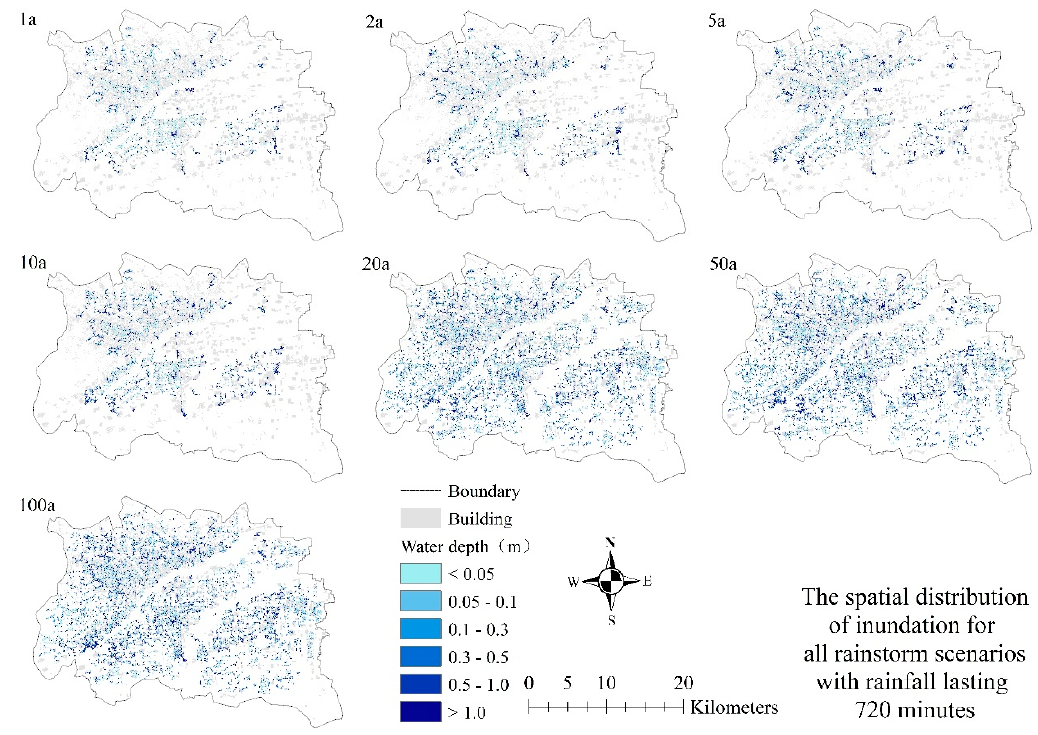
Figure 12. Spatial distributions of inundation for 720 min rainstorm scenarios.